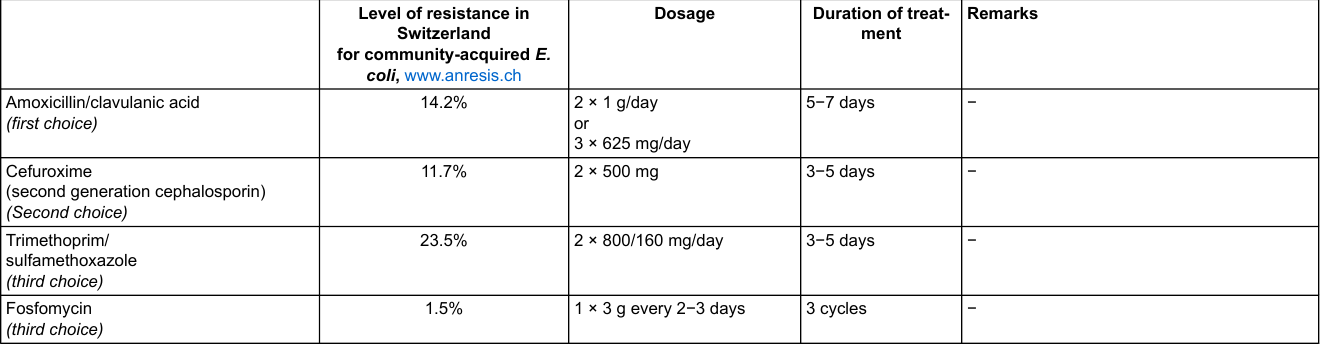
Table 4: Antibiotic therapy for complicated UTIs in non-pregnant women.